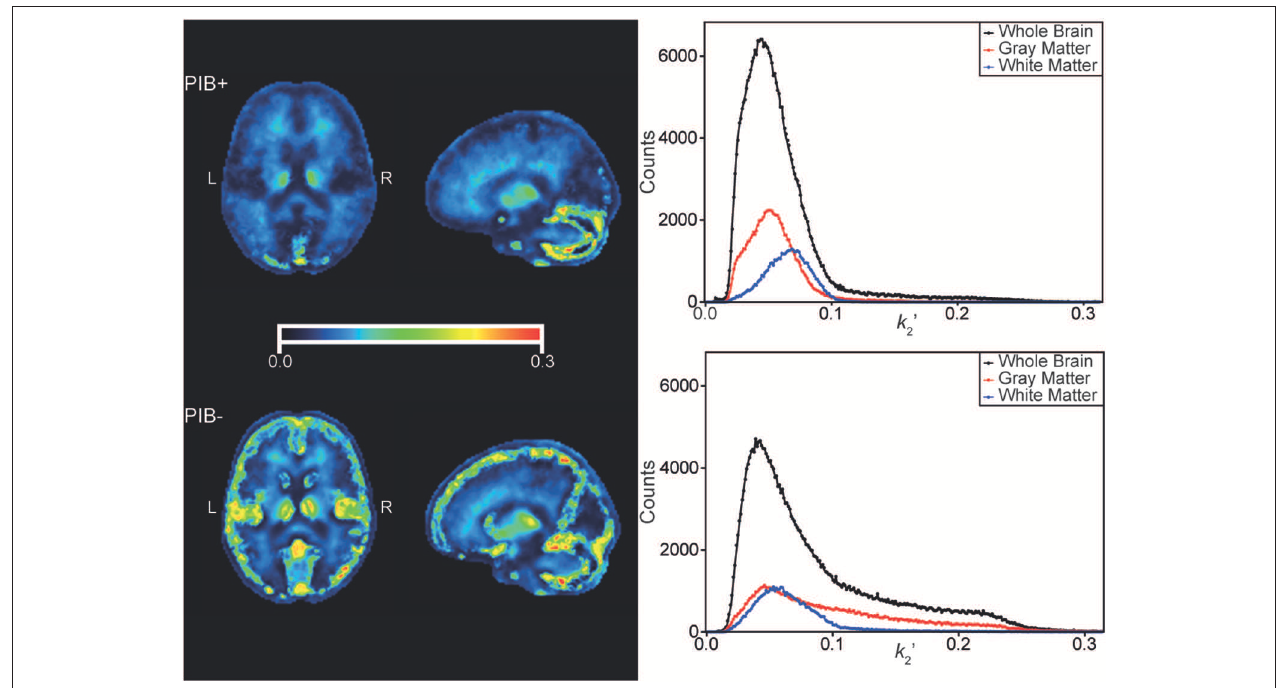
FIGURE 2 | Median k ′ 2 parametric maps of all subjects from the PIB + (top left), and PIB– (left bottom) groups. Shown are corresponding transaxial, and sagittal slices of the brain. Color scales were adjusted to the same range. On the right, the histograms containing the counts of k ′ 2 values from the voxels of the parametric maps on the left. Black dots and lines correspond to voxels contained inside the Whole Brain VOI, in red, of voxels from the Gray Matter VOI, and in blue, from the White Matter. The range of the histograms was adjusted to the same range of the color scale of the parametric maps.